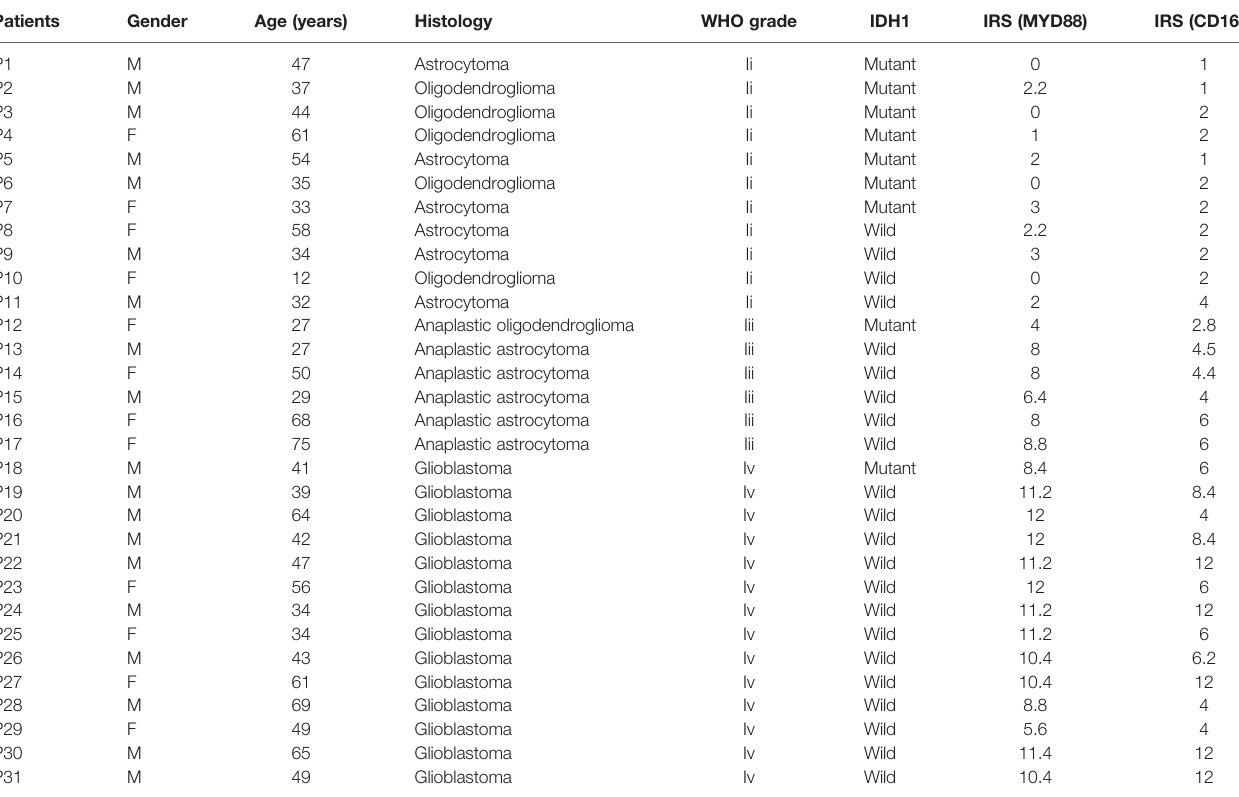
IRS means average immune reactive score based on fi ve random fi elds in each